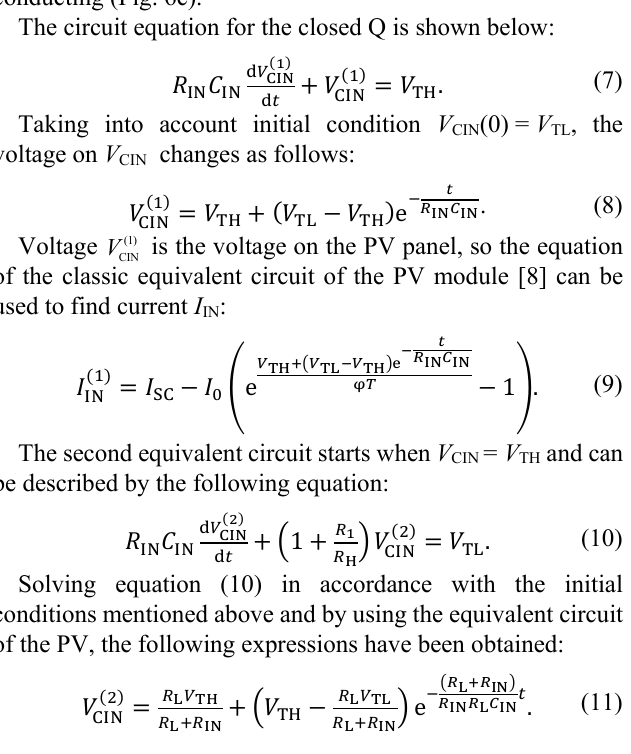
Fig. 5. MPP trajectory for changing the irradiance and temperature of the PV module.